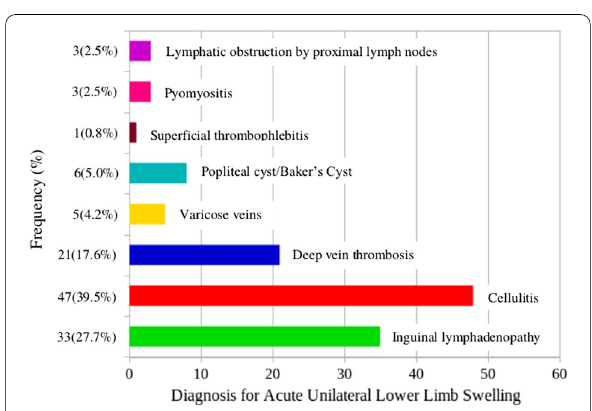
Fig. 9 Distribution of the final diagnoses for acute unilateral lower limb swelling from venous Doppler